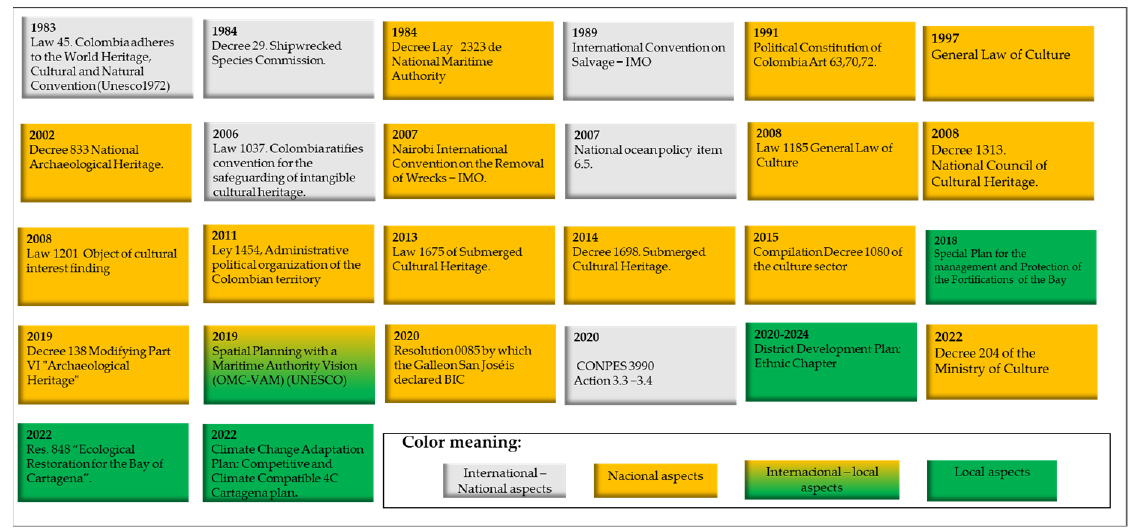
Figure 4. International, national, and local contests of some legal instruments concerning marine cultural heritage in Colombia.